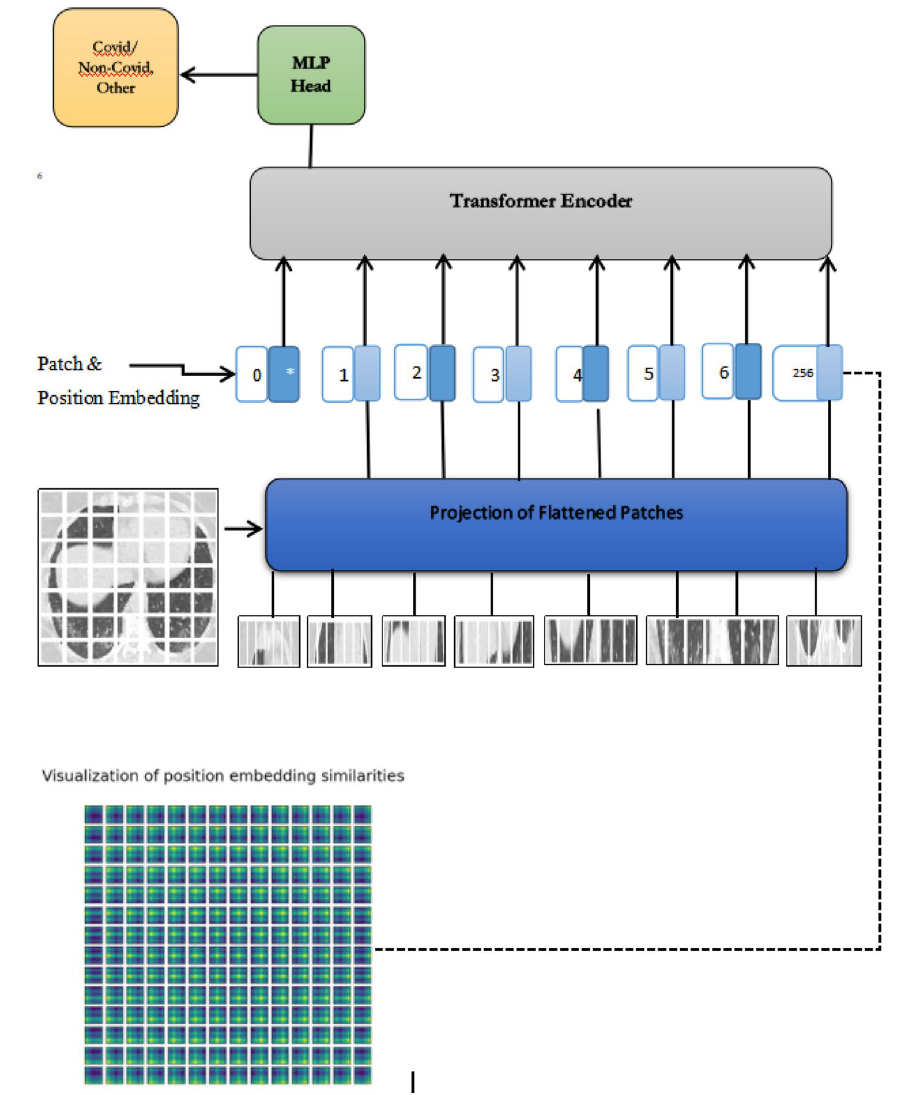
Figure 1. Overview of proposed approach.